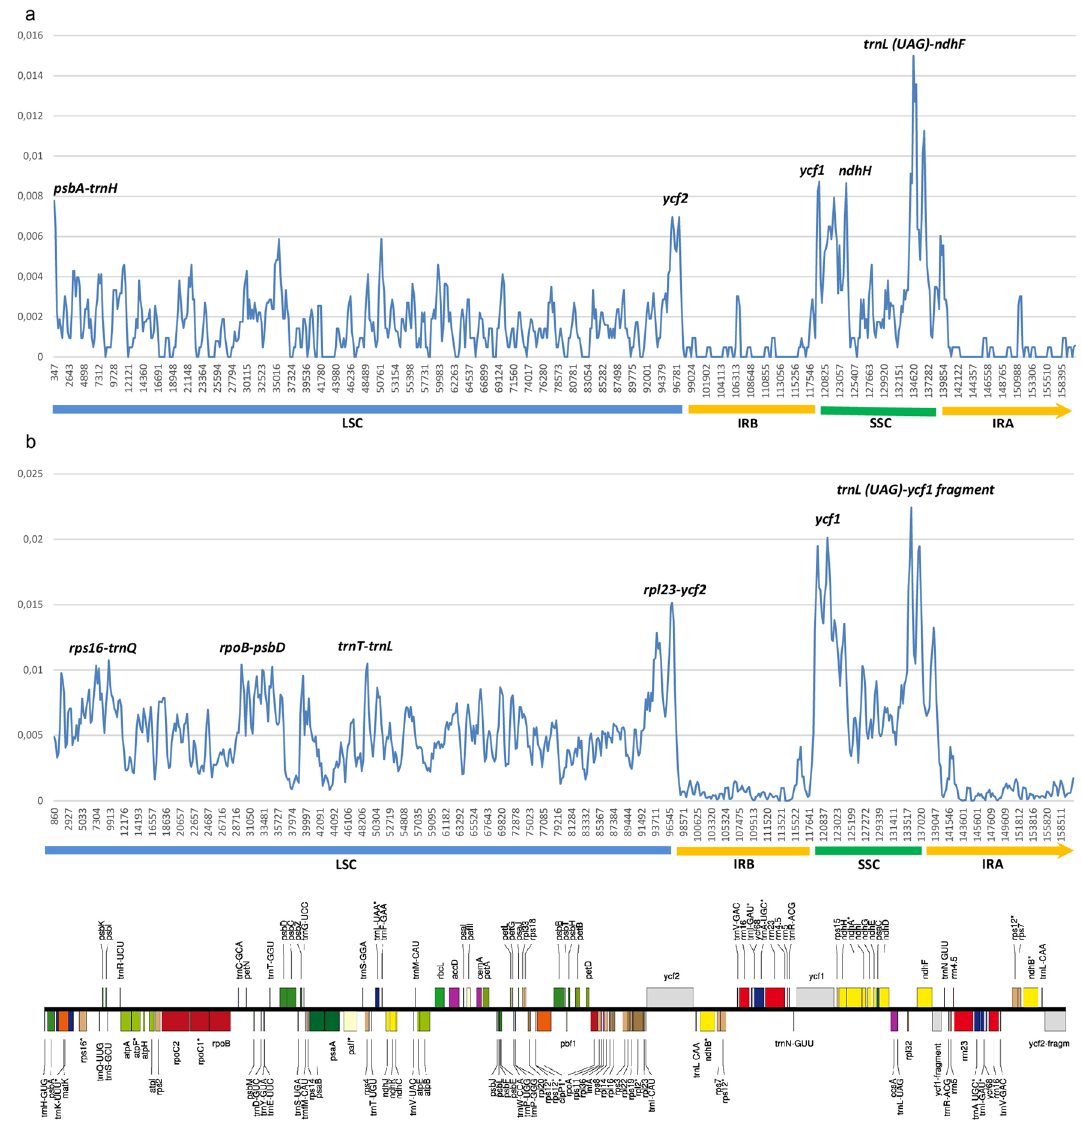
Figure 2. Comparison of the nucleotide variability (Pi) values, ( a ) among the seven Ocotea plastomes and ( b ) among 69 plastomes of Lauraceae. The linear gene map of Ocotea species is shown